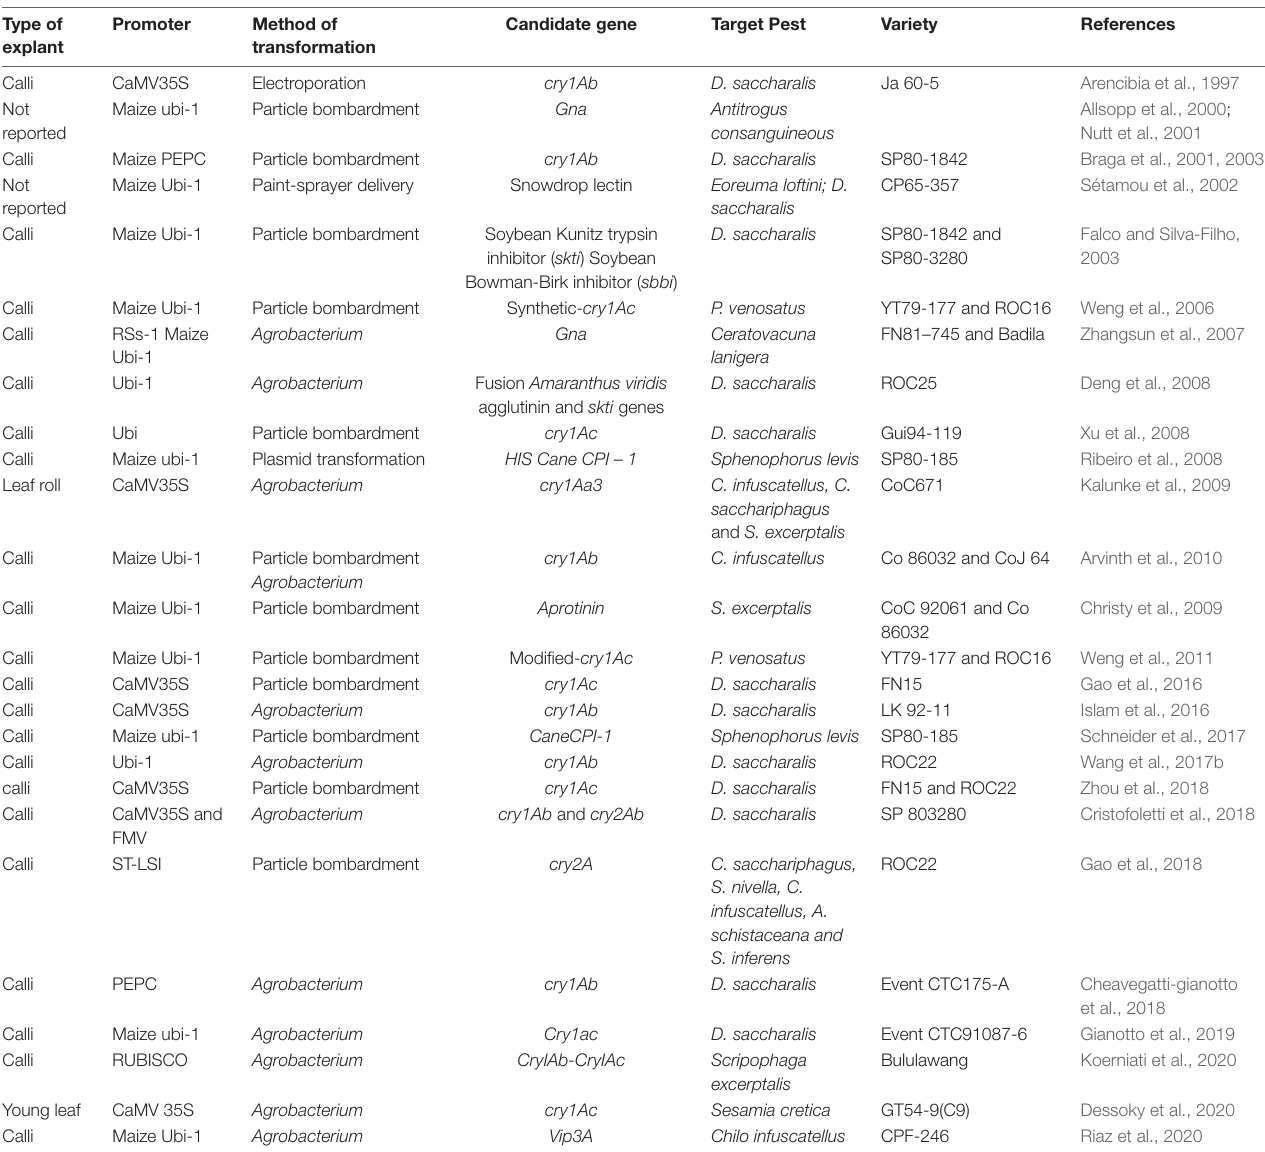
TABLE 3 | List of transgenic sugarcane engineered for pest